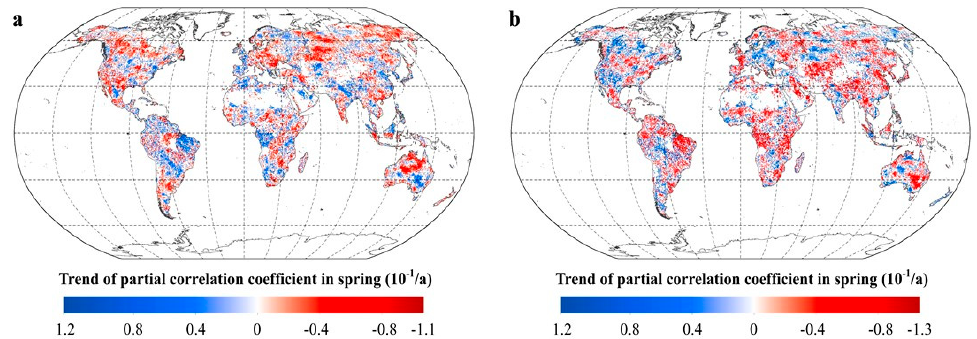
Figure 7. The response of vegetation greenness to the diurnal temperature in spring. ( a . spatial distribution of the temporal trend of the partial coefficients between spring NDVI and T max . b . spatial distribution of the temporal trend of the partial coefficients between spring NDVI and T min . Supplementary Table S2).